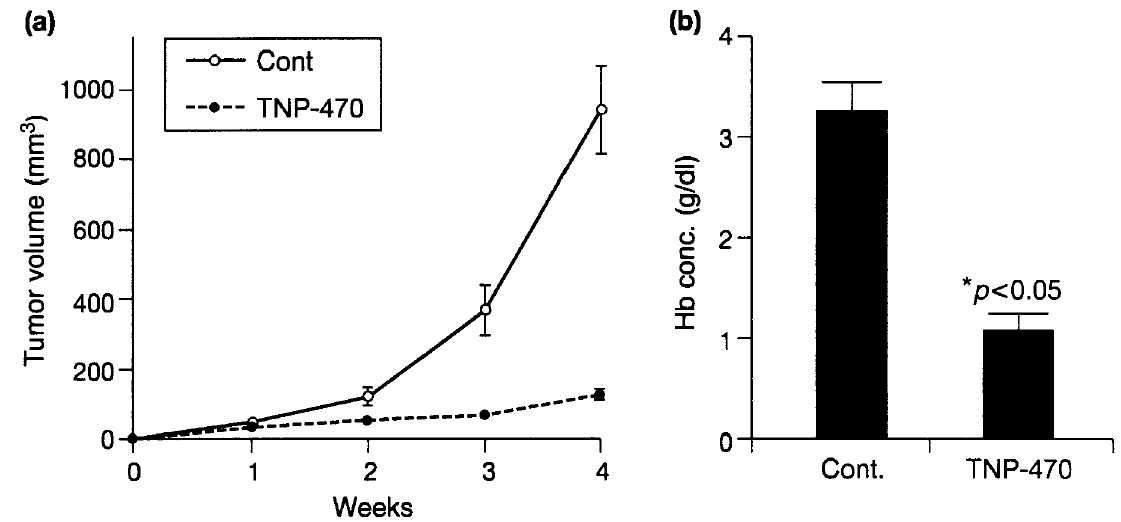
Fig. 1. The effects of TNP-470 on the in vivo growth of HT1080 human fibrosarcoma cells. (a) HT1080 human fibrosarcoma cells (1 3 10 6 ) were s.c. injected into nude mice. Tumor volume were measured weekly. Data are means from 3 independent experiments ± SEM. (b) Matrigel plug neovascularization was quantitated by measuring the hemoglobin content of the pellets using Drabkin’s meth- ods. Hemoglobin concentration was significantly lower in the mice of TNP-470 treated group. Columns, mean of 5 mice/group; bars, SE.